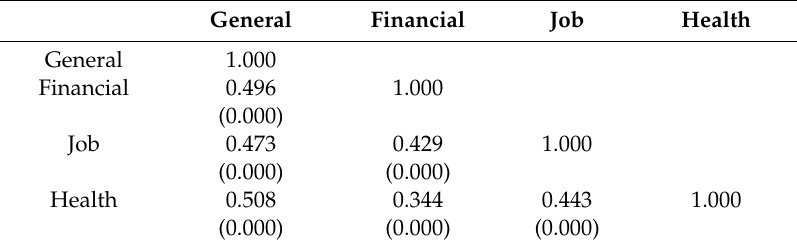
Table 1. Pearson’s correlation across domain satisfactions and general